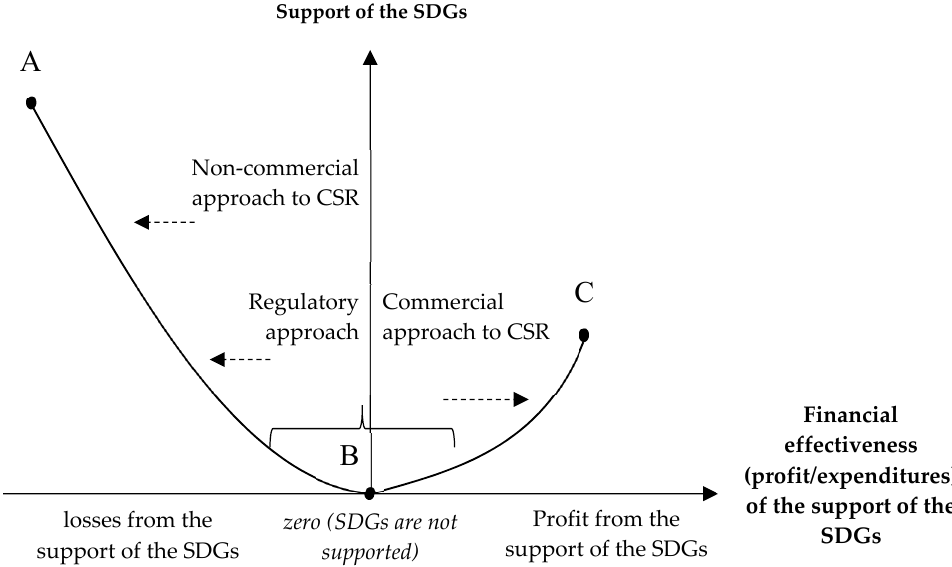
Figure 1. Bi-directional vector scale of the integration of the SDGs into corporate strategies from the positions of risk for profit in various distinguished approaches. Source: authors.